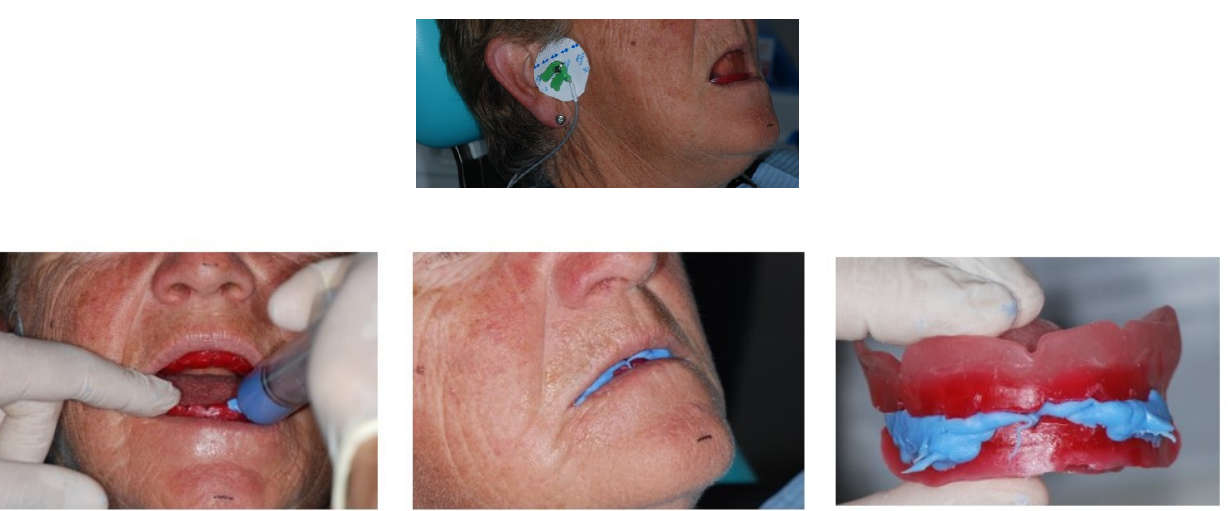
Figure 3. TENS (Trans Cutaneous Electrical Nerve Stimulation) stimulation with electrodes and detection with Myopront resin.